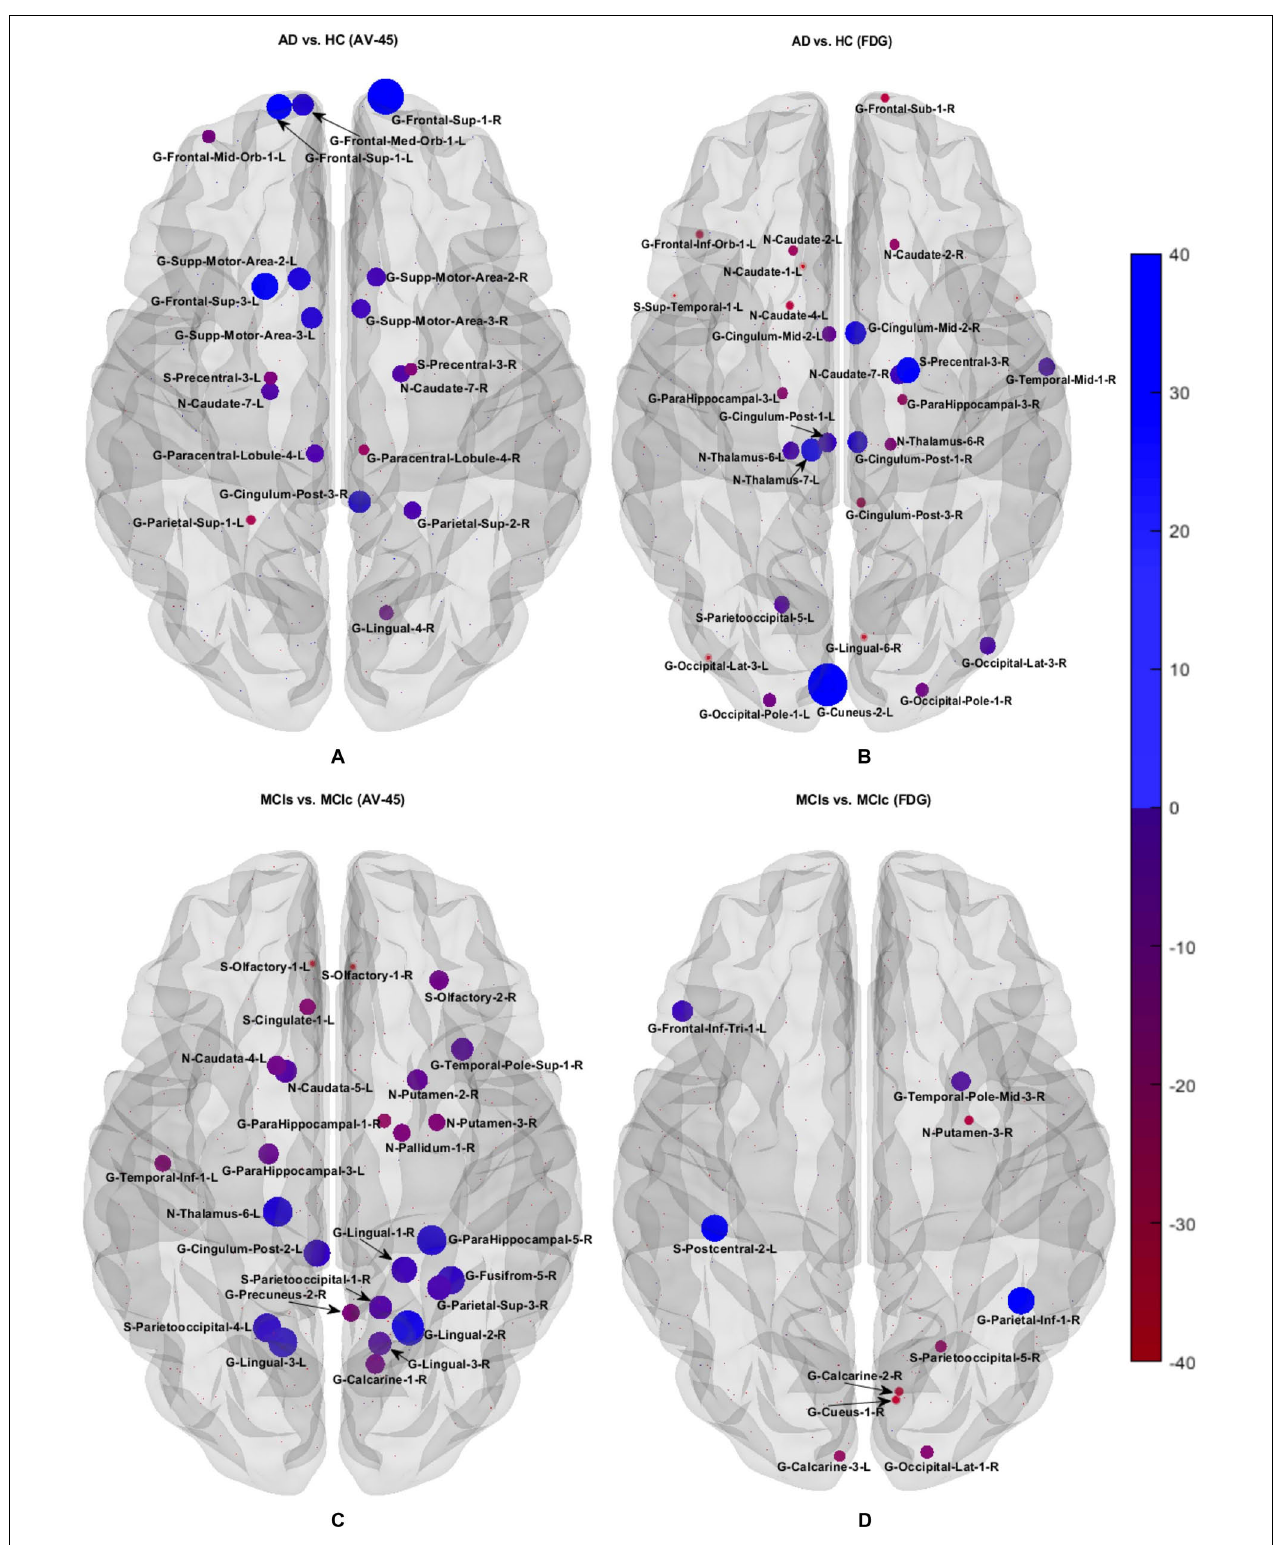
FIGURE 14 | Brain maps representing the most predictive regions for distinguishing between the AD vs. HC and MCIs vs. MCIs groups. Differences between groups in nodal measures. Nodes showing significant differences among groups in the nodal degree after FDR corrections. For both classification groups, AV45 and FDG show the most significantly affected regions. Dark blue shows the most significant region, whereas light red indicates the least significant region.